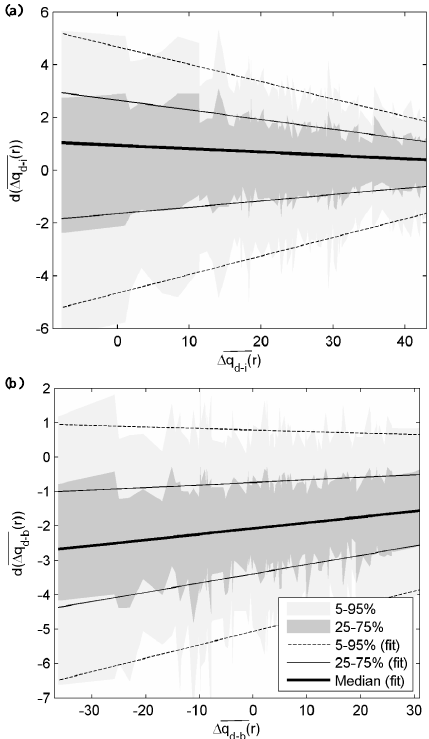
Fig. 5. 1q ( r ) versus d(1q ( r ) ) following parameter perturbation for (a) drained minus intact (b) drained minus blocked. Light grey areas: 5–95% range; dark grey areas: 25–75% range. The heavy black line is the best fit of the median, the dashed black lines are the best fit of the 25–75% range and the light grey lines are the best fit for the 5–95%